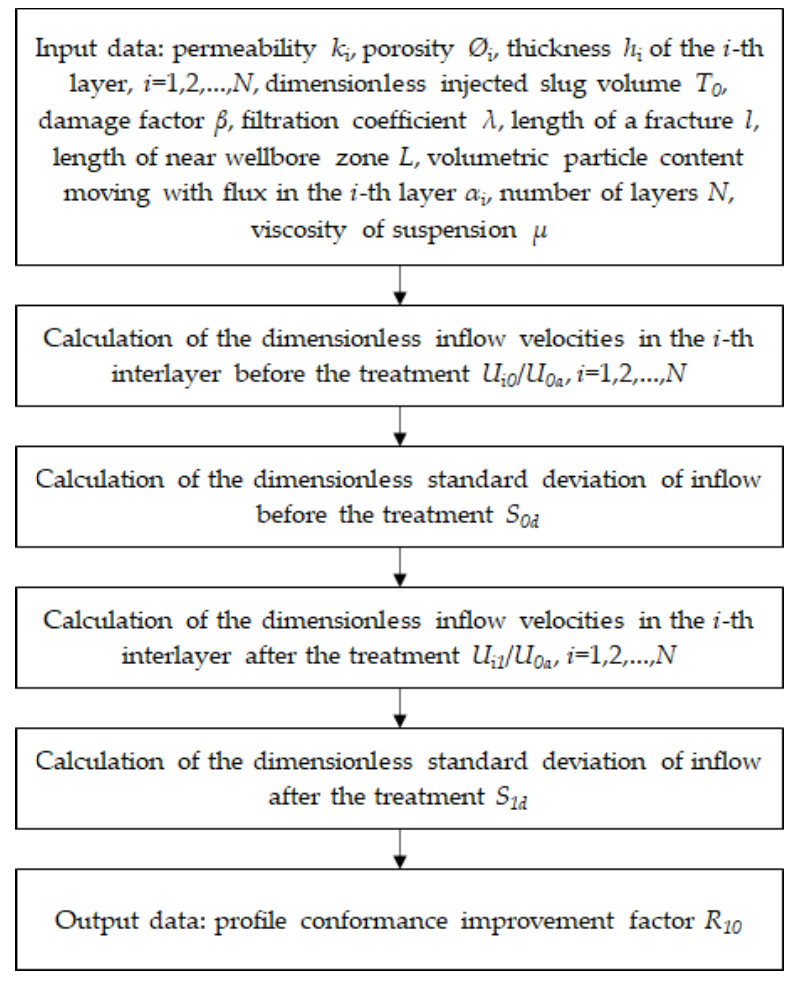
Figure 4. The schematic algorithm of calculation of conformance improvement factor.